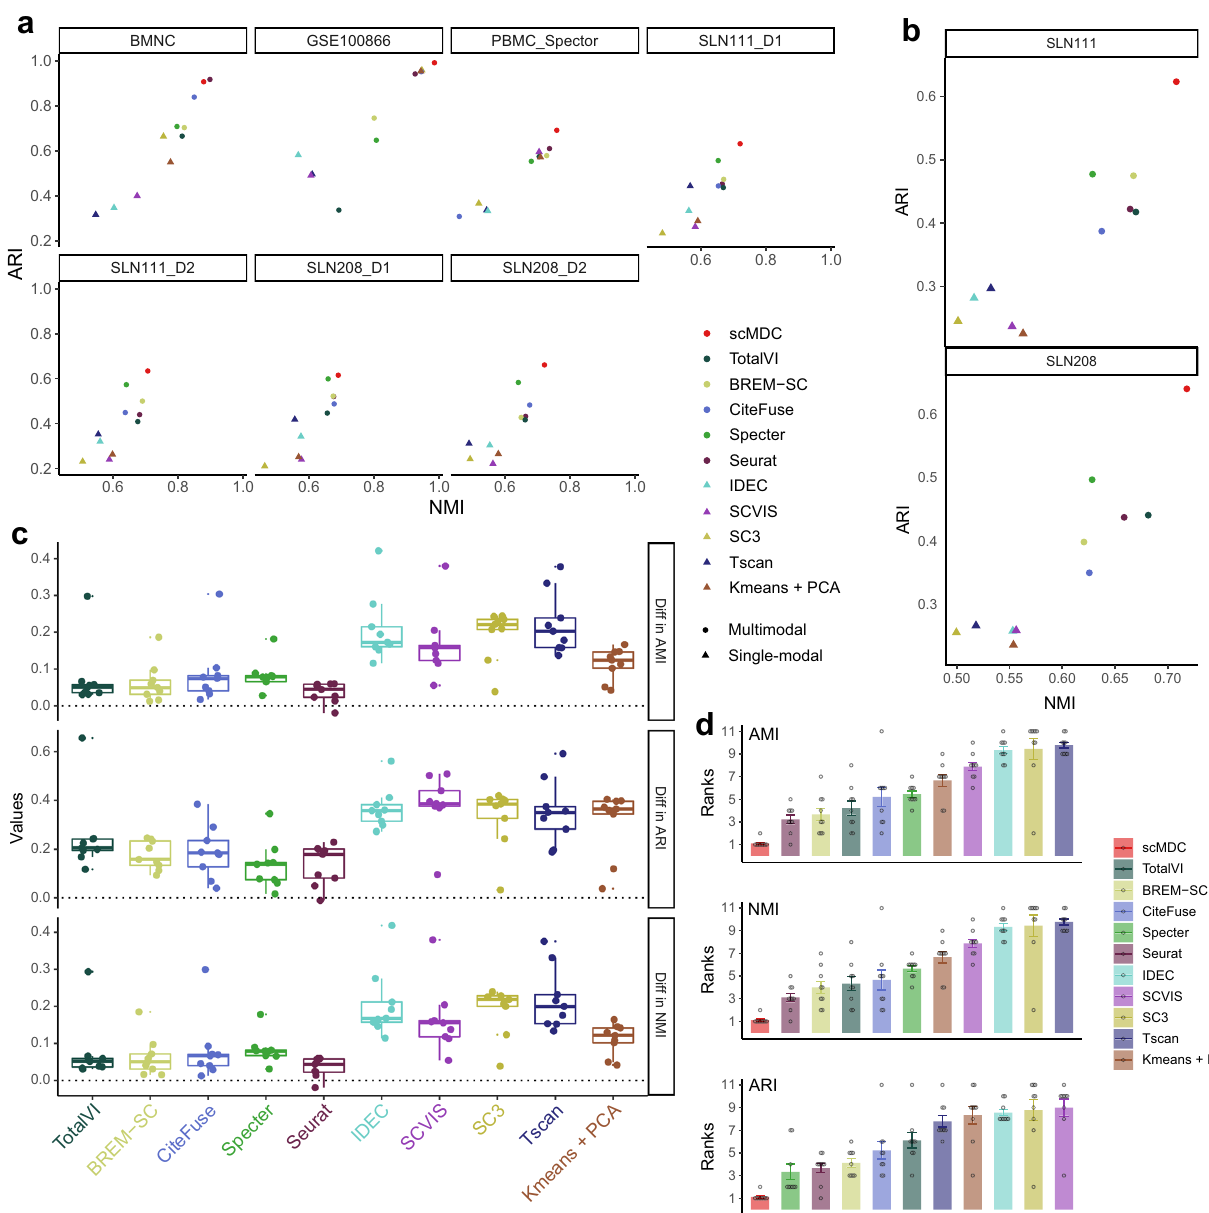
third quartile (Q3), and maximum of data. The minimum and maximum are the smallest data pointthatis equalto or greaterthanQ1 − 1.5*IQRand the largest data point that is equal to or less than Q3 + 1.5*IQR, respectively. Each data point (a differenceofperformance inadataset)isshownbyadot. Wealso summarized the performance of each method by showing the averaged ranks ( d , n = 9). Each data point(arankofamethodinadataset)isshownbyadotandthestandarderrorsare shown by the error bars. In panels ( c ) and ( d ), clustering performance is evaluated by AMI, NMI, and ARI. Source data is provided as a Source Data fi